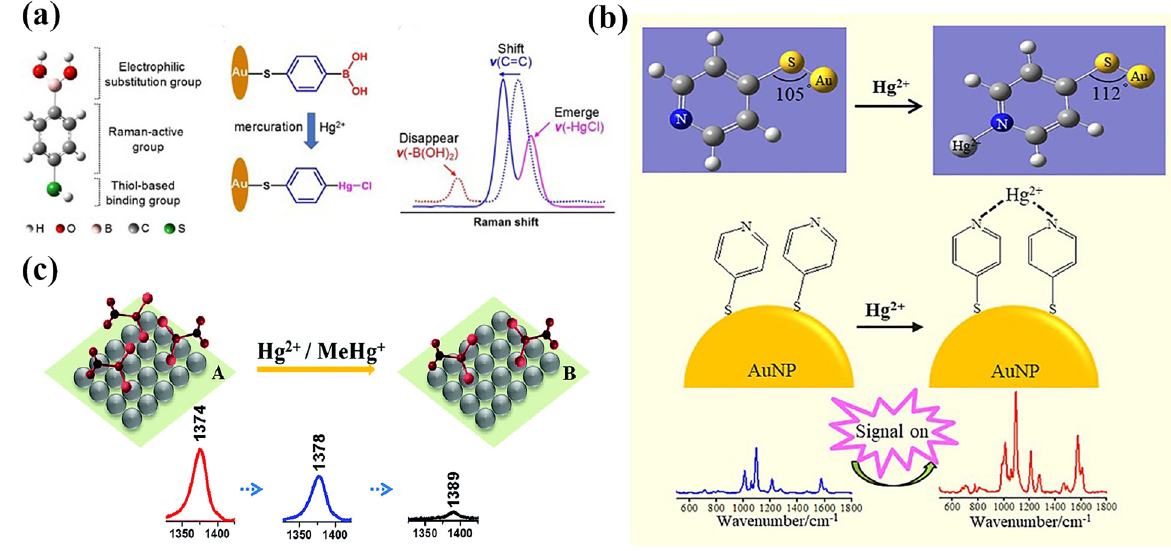
Figure 1: Detection of Hg 2 + through SERS-active MREs reacting with Hg 2 + ions. (a) Recognizing Hg 2 + ions through electrophilic substitution reaction between Hg 2 + and 4-MPBA [54]. (b) Recyclable 4-MPy/AuNPs/ITO chips forHg 2 + ionsdetection[55].(c)SERSfrequency-shiftmethodtodetermineHg 2 + orMeHg + viabindingwithdimethyldithiocarbamicacidsodium salt (DASS)